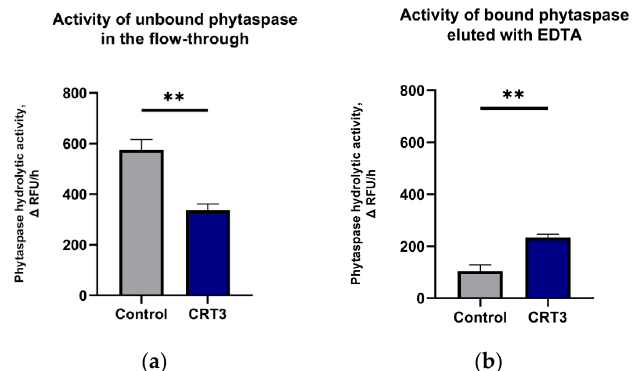
Figure 6. Evidence for direct in vitro interaction of Nt Phyt with calreticulin ‐ 3. Recombinant